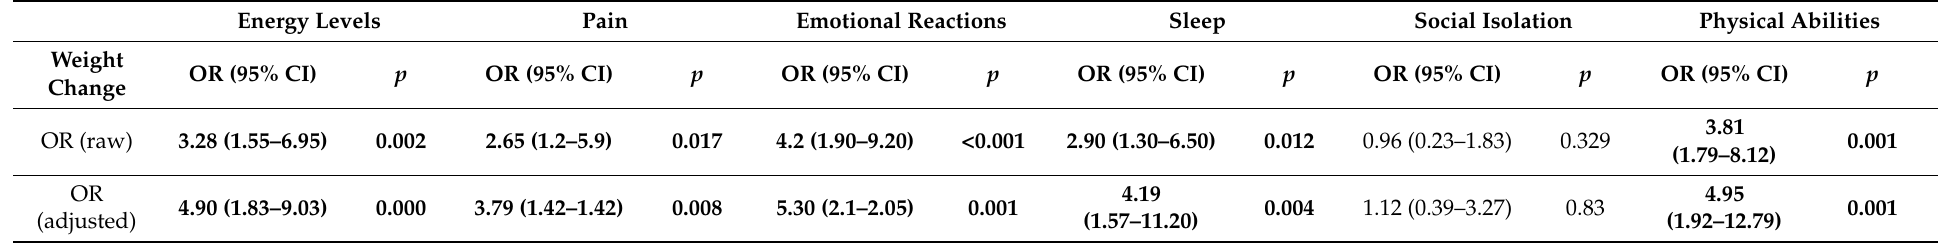
Table 2. Multivariate logistic regression models to assess the effect of weight change on QoL improvement. The table shows the model unadjusted (raw) and adjusted to sex, age, palliative treatment, and stool consistency improvement. Data are expressed as odds ratios (OR) with 95% CI and p -values. Bold text indicates significant